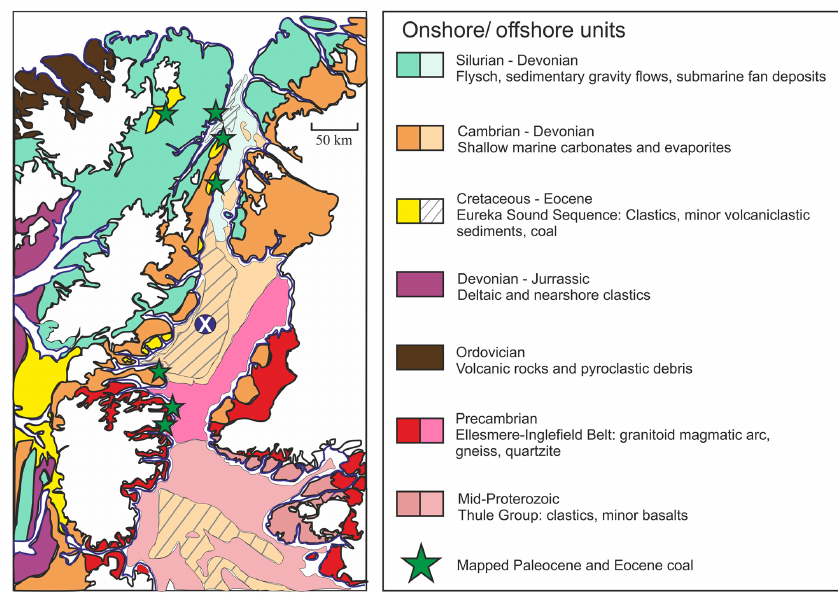
Figure 2. Geology of Northwest Greenland and Ellesmere Island along Nares Strait. Adapted from Harrison et al.